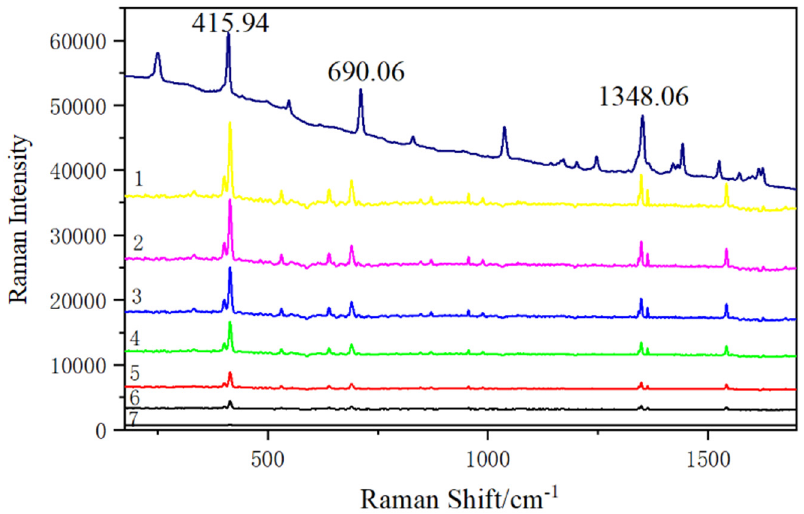
Figure 9. The detection limit of phenanthrene obtained on Fe 3 O 4 @PDA@Au@GO nanocomposite SERS substrate (phenanthrene solid. (1): 10 − 2 g/L phenanthrene SERS solution. (2): 10 − 3 g/L phenanthrene SERS solution. (3): 10 − 4 g/L phenanthrene SERS solution. (4): 10 − 5 g/L phenanthrene SERS solution. (5): 10 − 6 g/L phenanthrene SERS solution. (6): 10 − 7 g/L phenanthrene SERS solution. (7): 10 − 8 g/L phenanthrene SERS solution).